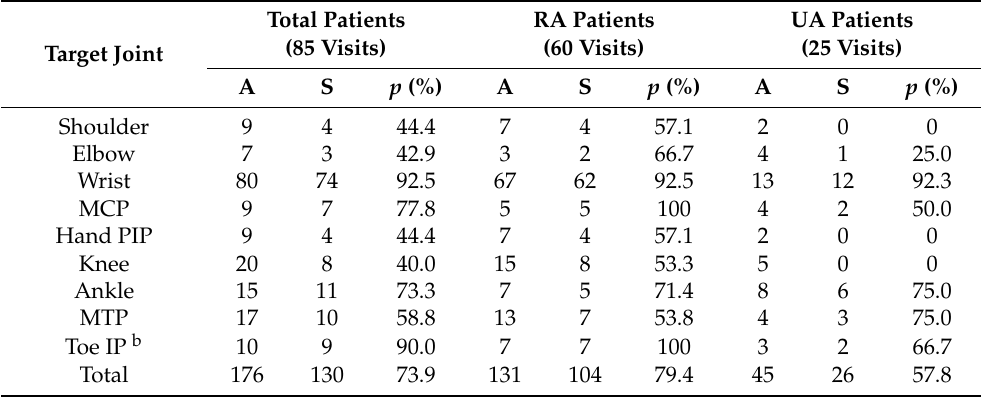
Table 2. Distribution of target joints with arthritic signs (A) and proportions ( p ) of ultrasonography proven synovitis (S) a .